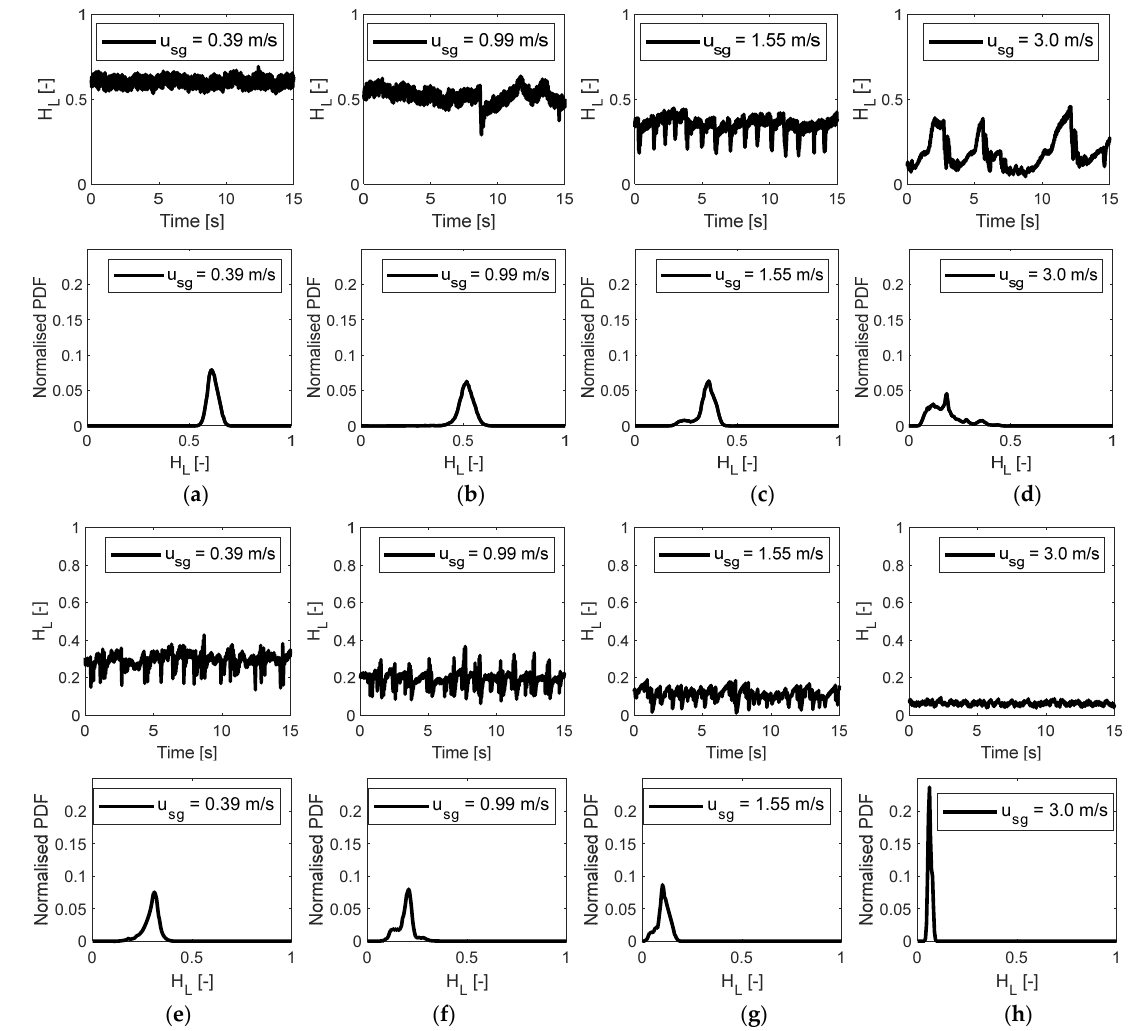
Figure 5. WMS PDFs of holdup for u sl = 1 m/s and u sg = 0.39–3.00 m/s. ( a – d ) flowline injection ( e – h ) riser base